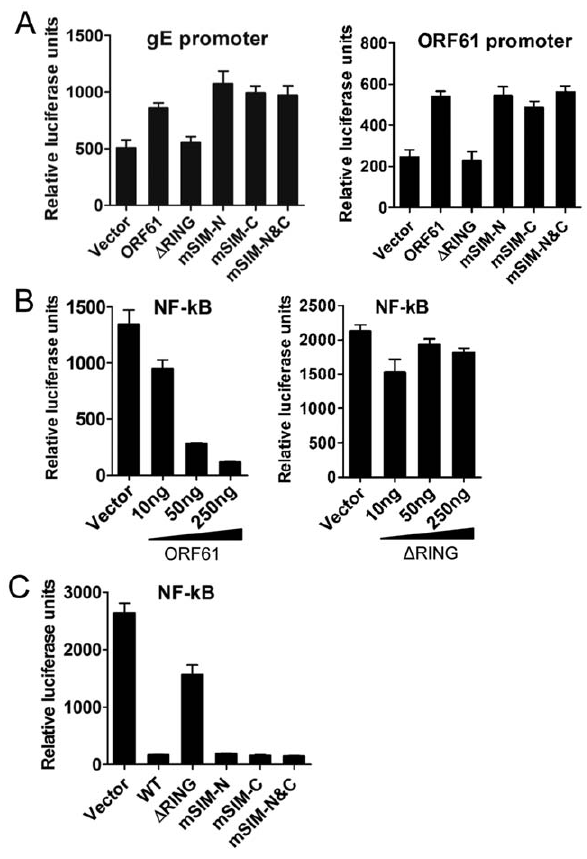
Figure 3. ORF61 SIMs are dispensable for other ORF61 functions. (A) The effect of ORF61 SIM mutants on gE promoter (left panel) and ORF61 promoter (right panel). Luciferase assays were performed on melanoma cells transfected with gE promoter or ORF61 promoter construct and pcDNA constructs expressing ORF61 D RING mutant and SIM mutants. (B) NF- k B suppression by ORF61 and D RING mutant. Luciferase assays were performed on melanoma cells that were cotransfected with NF- k B reporter plasmid and increasing amounts (10- 250 ng) of pcDNA-ORF61 (left panel) or pcDNA-ORF61( D RING) (right panel) and then treated with TNF- a . (C) NF- k B suppression by ORF61 SIM mutants. Luciferase assays were performed on melanoma cells that were transfected with NF- k B reporter plasmid and a fixed amount (250 ng) of pcDNA constructs expressing ORF61 SIM mutants and then treated with TNF- a . The graphs show the relative luciferase units ( firefly